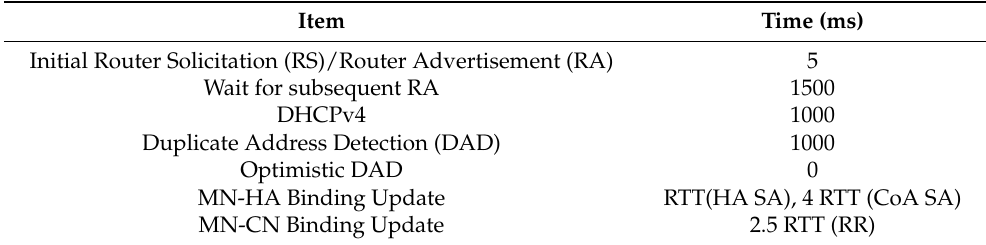
Table 2. Layer 3 handover delay